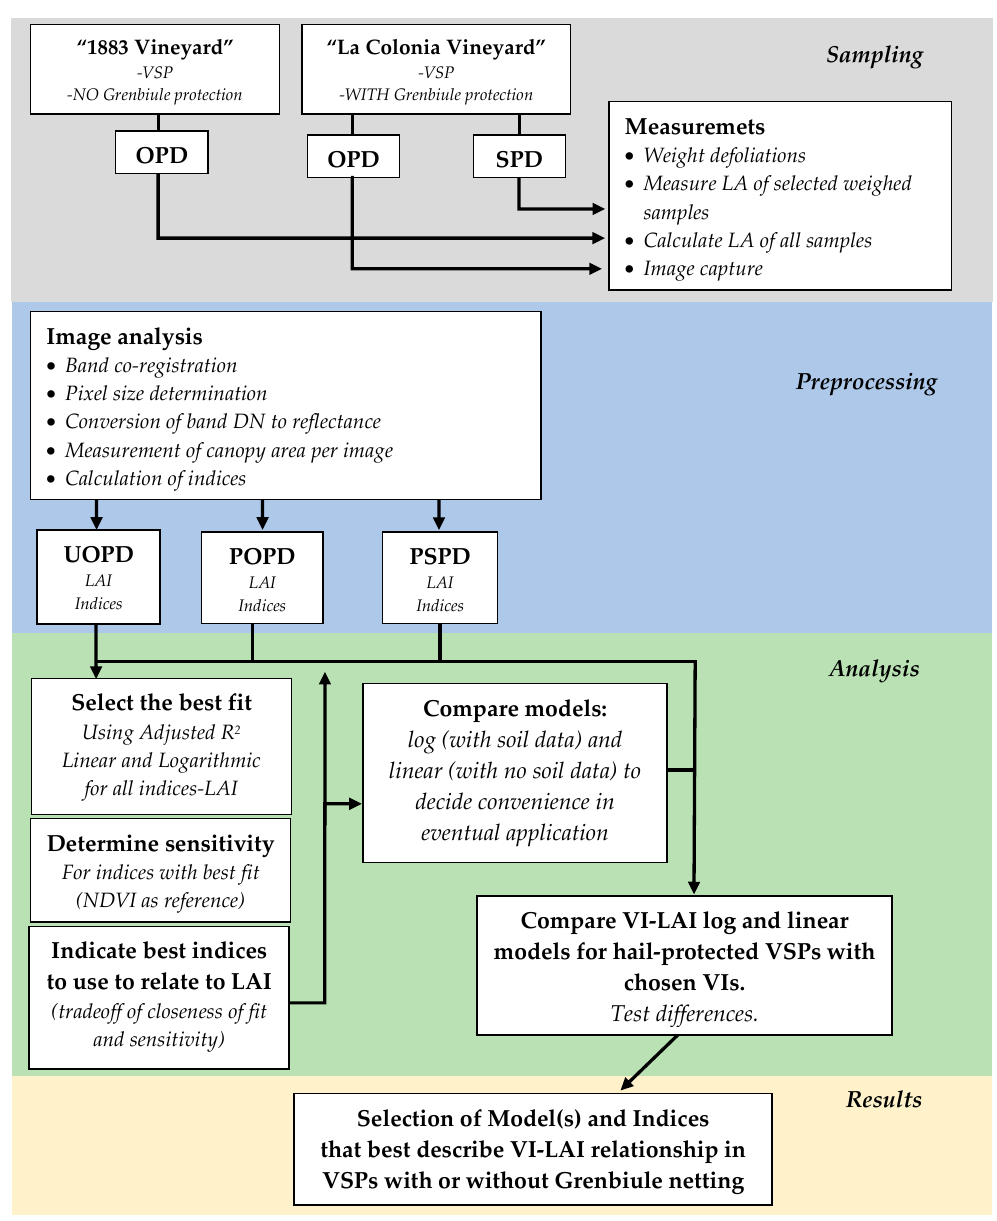
Figure 4. Schematic view of the full procedure used in this study.